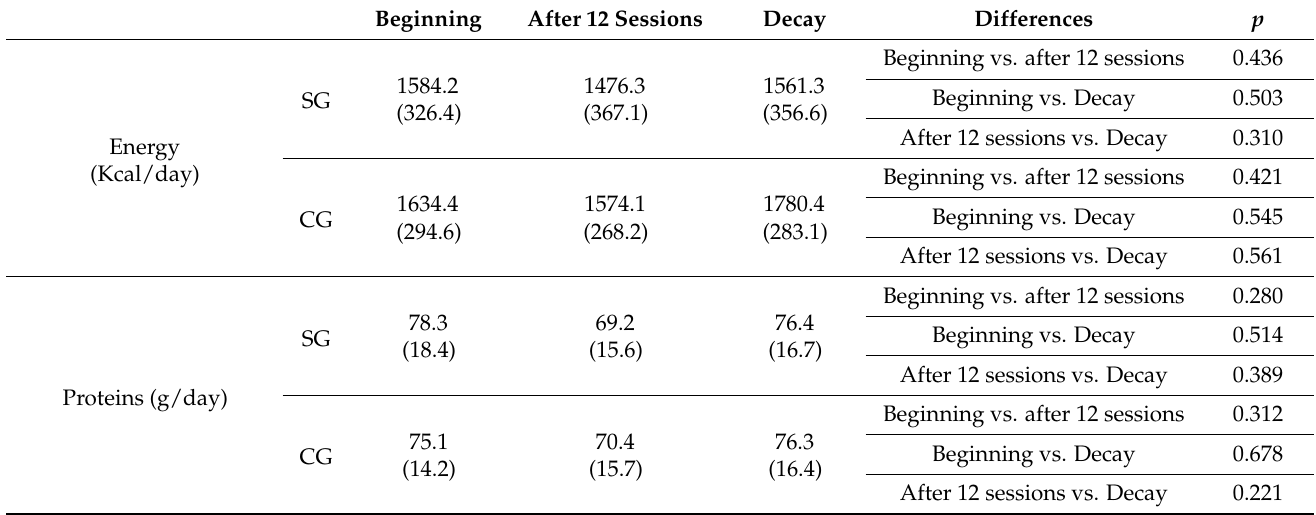
Table 3. Nutritional intake of macronutrients in both groups during the